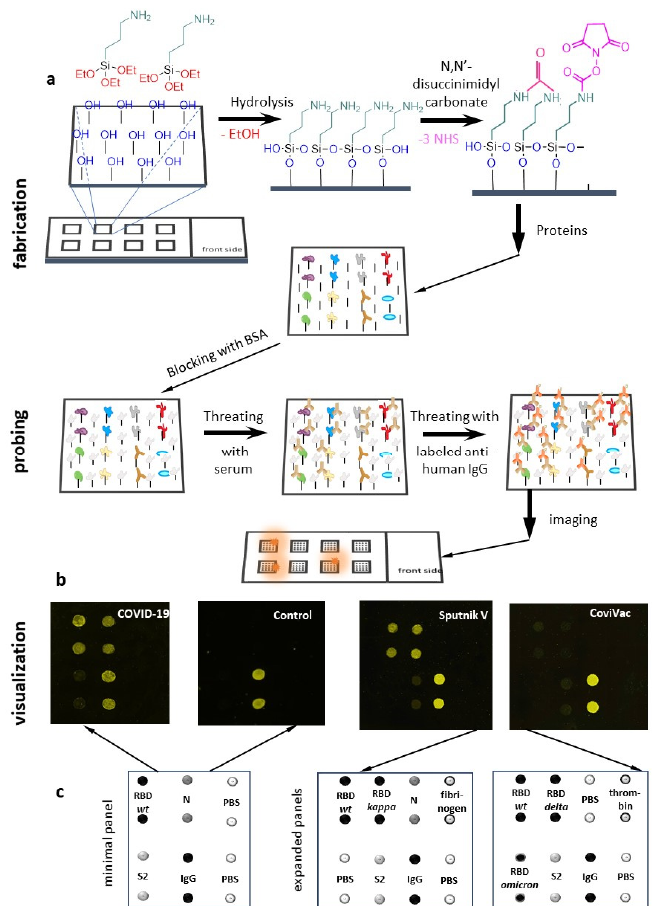
Figure 1. Microarray design and operation principle. ( a ) Schematic representation of the array fabrication scheme and the Ab profiling pipeline; ( b ) Examples of array scans; ( c ) The panels of antigens for Ab profiling.